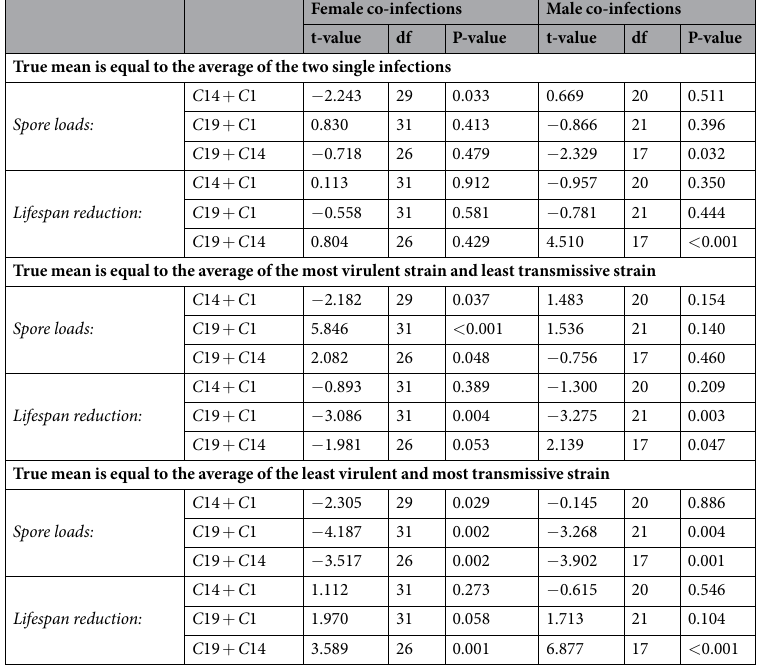
Table 2. Tests of equality between the production of spores and the relative reduction in lifespan in the co- infection treatments. Presented are one sample t-tests comparing the co-infection treatment groups against the predicted means of various single infection outcomes. We compared virulence under coinfection with that expected based on interference competition (intermediate values), competition for resources (higher values than most virulent) or spite (lower values than the least virulent). The sign of the t-value indicates whether the co-infection outcome was lower or higher than